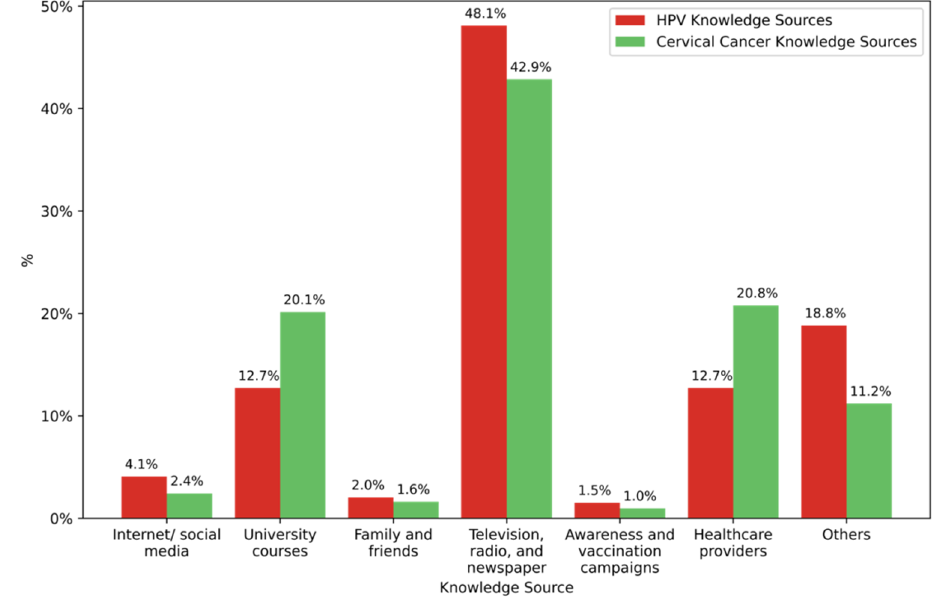
Figure 1. The different knowledge sources used by the participants to learn about cervical cancer and HPV.